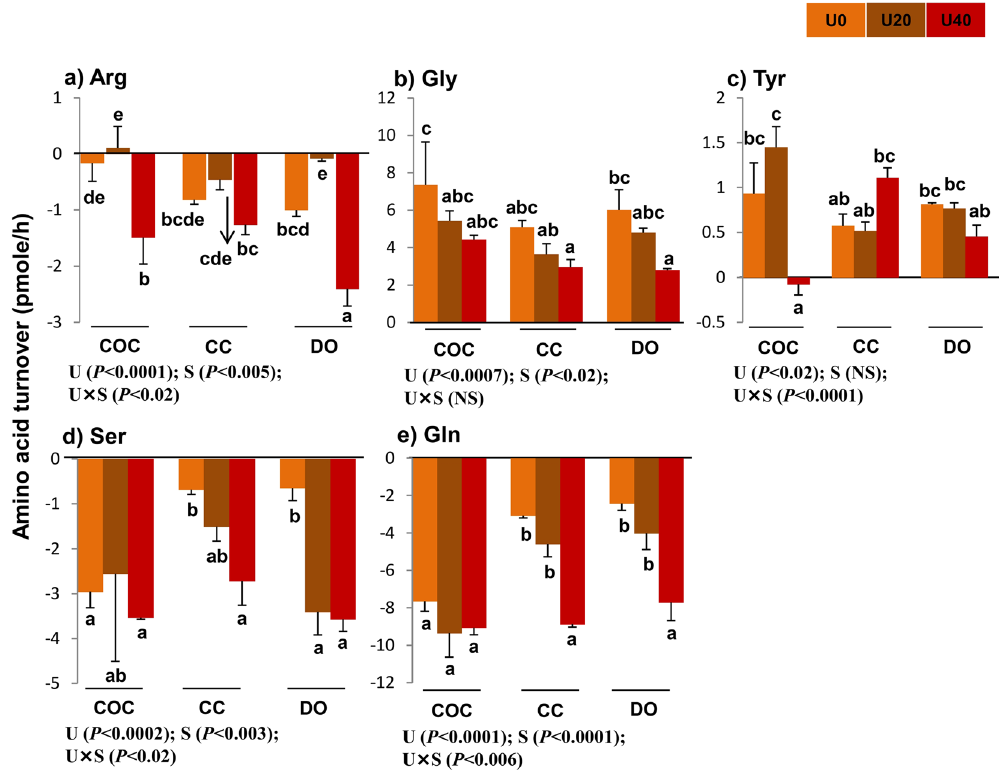
Figure 4. Effect of urea supplementation (0, 20, or 40 mg/dl) in maturation medium on the net depletion/ appearance of semi-essential amino acids by bovine cumulus-oocyte complex, oocytectomized cumulus cells, or denuded oocytes after 24-h incubation. U0: control group (without urea); U20: 20 mg/dl urea; U40: 40 mg/ dl urea. COC: cumulus-oocyte complex; CC: cumulus cells; DO: denuded oocytes; U: the main effect of urea; S: the main effect of specimens (cell type: COCs, DOs, and CCs); U × S: interaction between urea and cell type. Data are presented as least squares means (LSM) ± standard error mean (SEM) indicated by two-way ANOVA over PROC GLM. Different letters (a, b, c, etc.) indicate significant differences between the treatments at P < 0.05. NS: